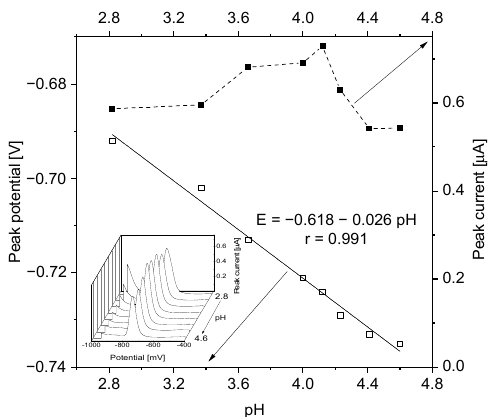
Figure 1. Dependence of peak current and potential on pH value. Instrumental parameters: Δ E = 30 mV, Es = 4 mV, tw, tp = 10 ms. Stirring rate, 500 rpm.